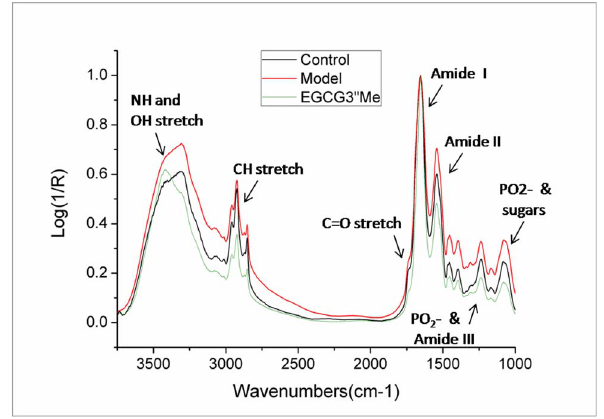
Figure 6. Kidney tissues morphologies were detected in processed IR spectroscopic maps. IR spectra of control group (black), model group (red), and EGCG3’’Me-treated group (green) normalized to the amide I band. Arrows indicate the relevant phospholipid peaks of the C–H stretch band at 2922 cm –1 , the C=O stretch at 1740 cm –1 , and the phosphate bands at 1080 and 1240 cm –1 in the model and decreased by EGCG3’’Me, which indicated that EGCG3’’Me decreasing lipid and other cell